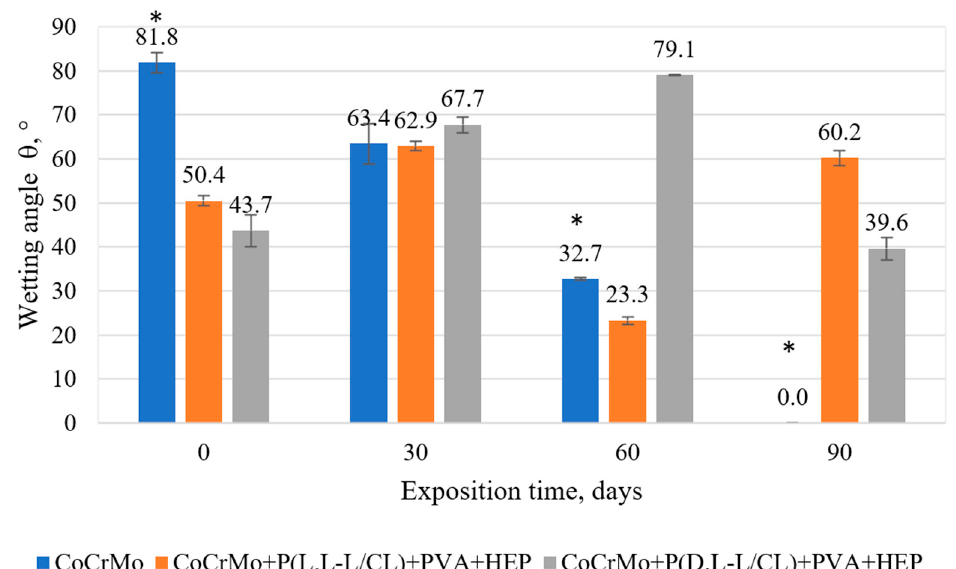
Figure 2. Values of the contact angle for the tested variants of surface modification (* p < 0.05 versus